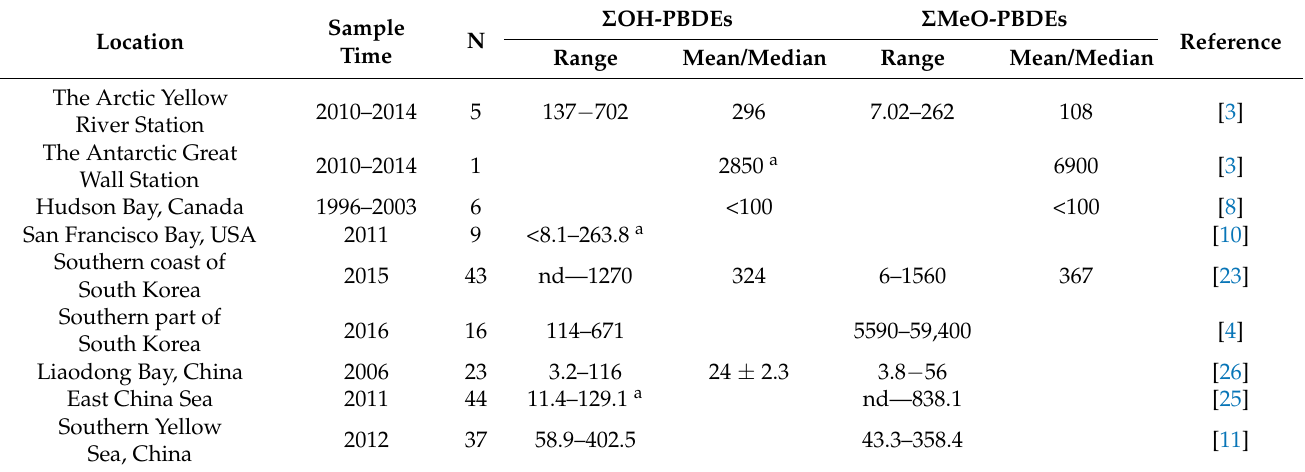
Table 2. Concentrations of OH/MeO-PBDEs in marine sediments (pg/g